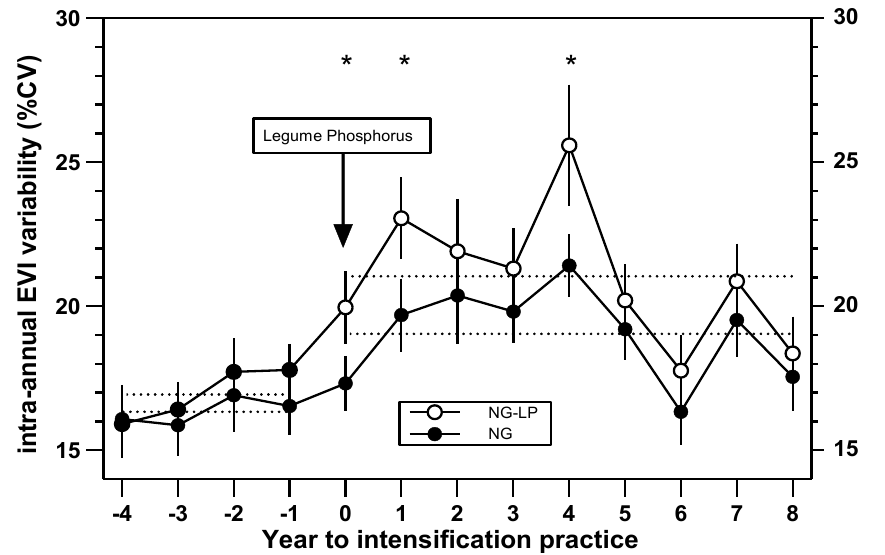
Figure 4. Intra-annual Enhanced Vegetation Index (EVI) variability of natural grassland four years before, and of the natural grassland (NG) and natural grassland overseed with legumes and fertilized with phosphorus (NG-LP), over nine years of intensification (year 0, arrow inside the panel). Points correspond to intra-annual Coefficient of Variation (CV) mean of 20 paddocks (NG, n = 20, NG-LP, n = 20), error bars indicate spatial standard error, horizontal dotted lines intra-annual CV mean (before intensification practice, F = 4, p value = 0.06; after intensification practice, F = 24.1, p value < 0.0001). Asterisks above indicate significantly different years (T ≥ 3.2, p value p ≤ 0.05).